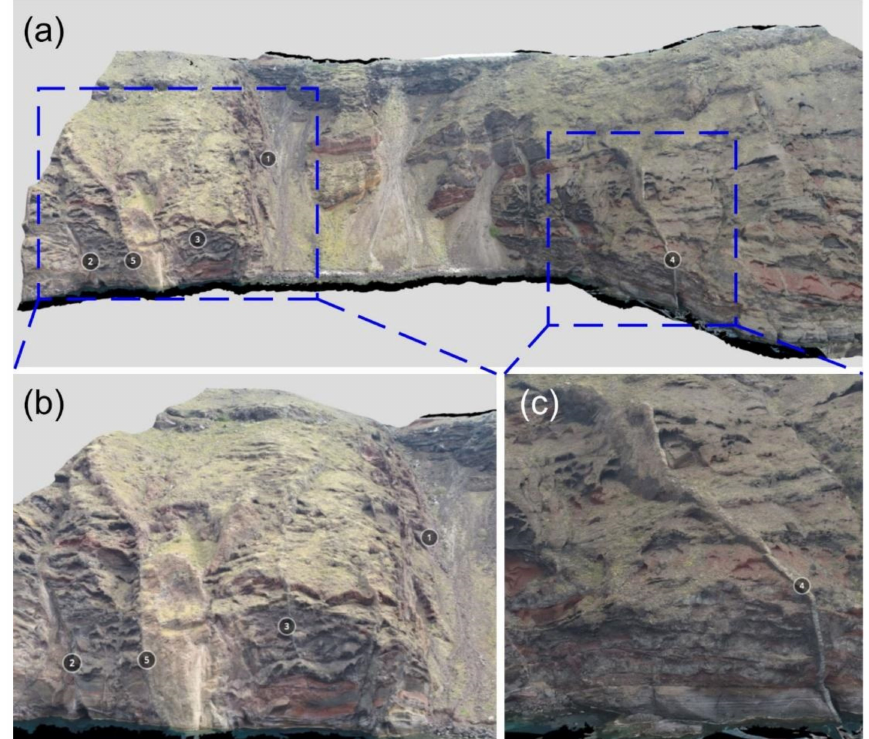
Figure 8. ( a ) A 3D model of the NE corner of the northern caldera wall (view towards the northeast). The cliff is 190 m high. ( b ) A closer look of the left part of the outcrop where dikes are emplaced in the caldera wall, with some showing deflection into the fault zones. ( c ) A 3D view of a dike that dissects the caldera